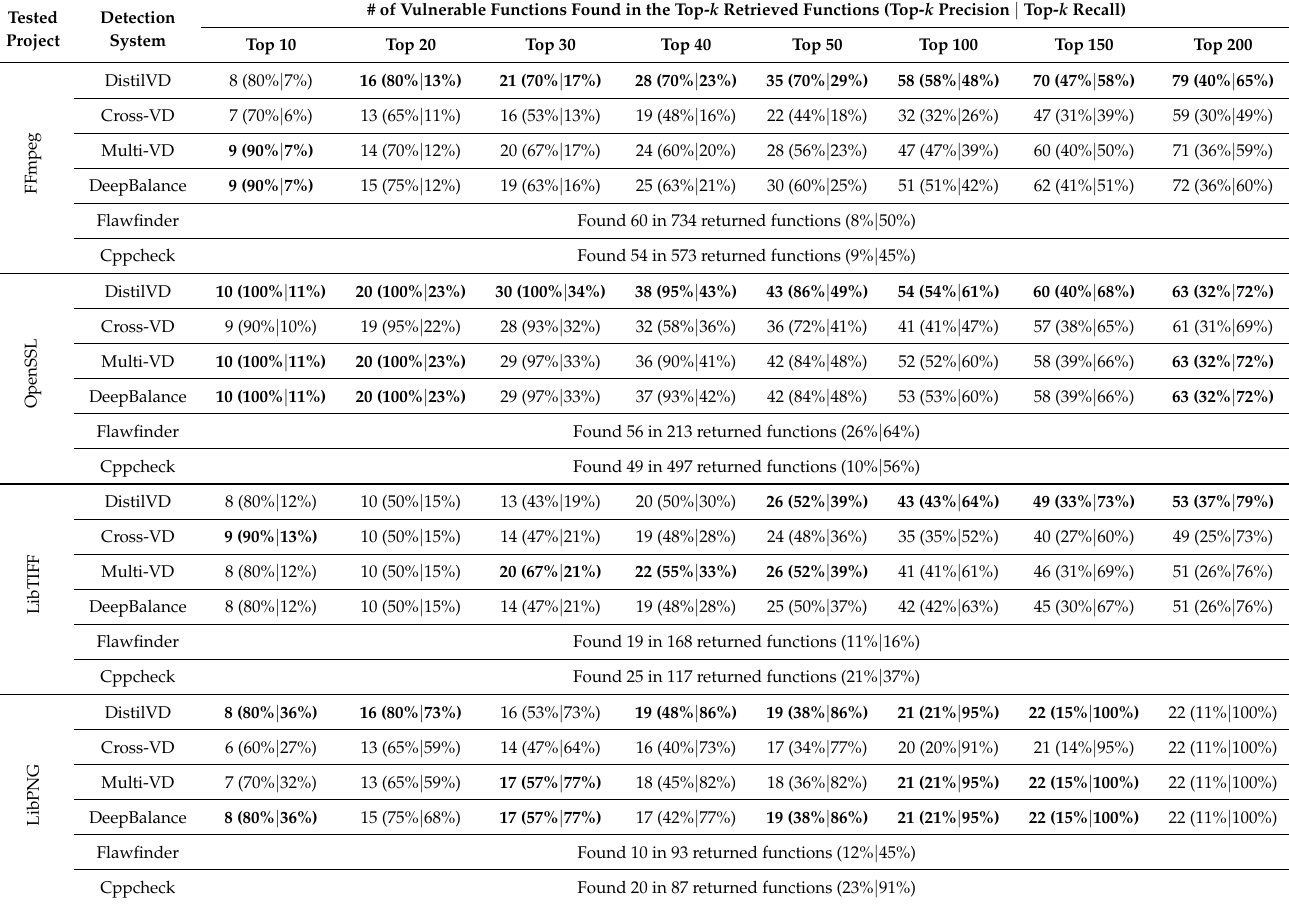
Table 7. Comparative results of DistilVD with different function-level vulnerability detection